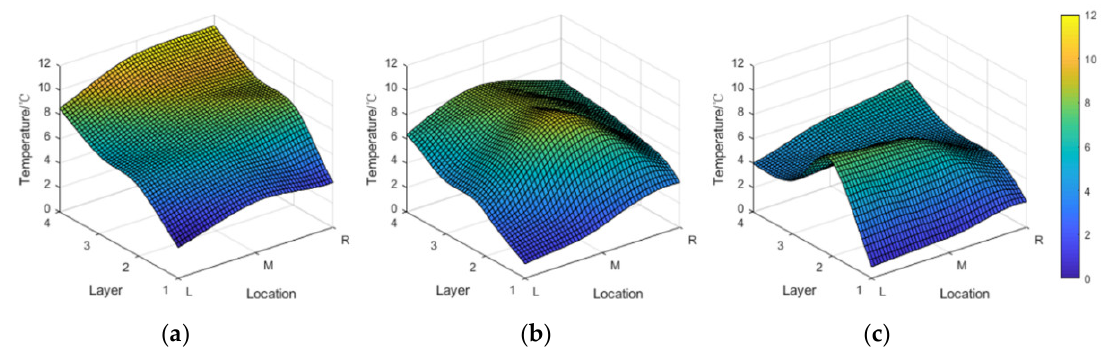
Figure 8. Temperature distributions in the cabinet. ( a ) 0%. ( b ) 25%. ( c ) 50%.